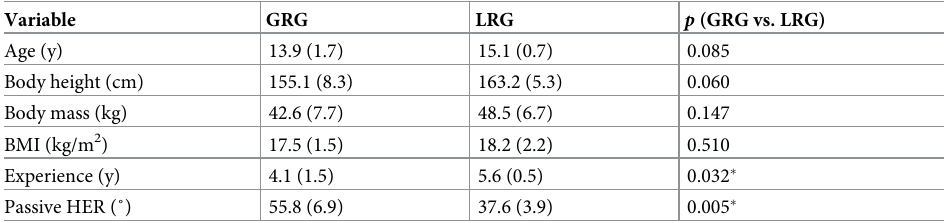
SD = standard deviation; GRG = greater rotation group; LRG = lesser rotation group; y = years; cm = centimeter; kg = kilogram; m = meter; BMI = body mass index; HER = hip external rotation angle; ˚ = degree. � Significant differences ( p � 0.05) between the